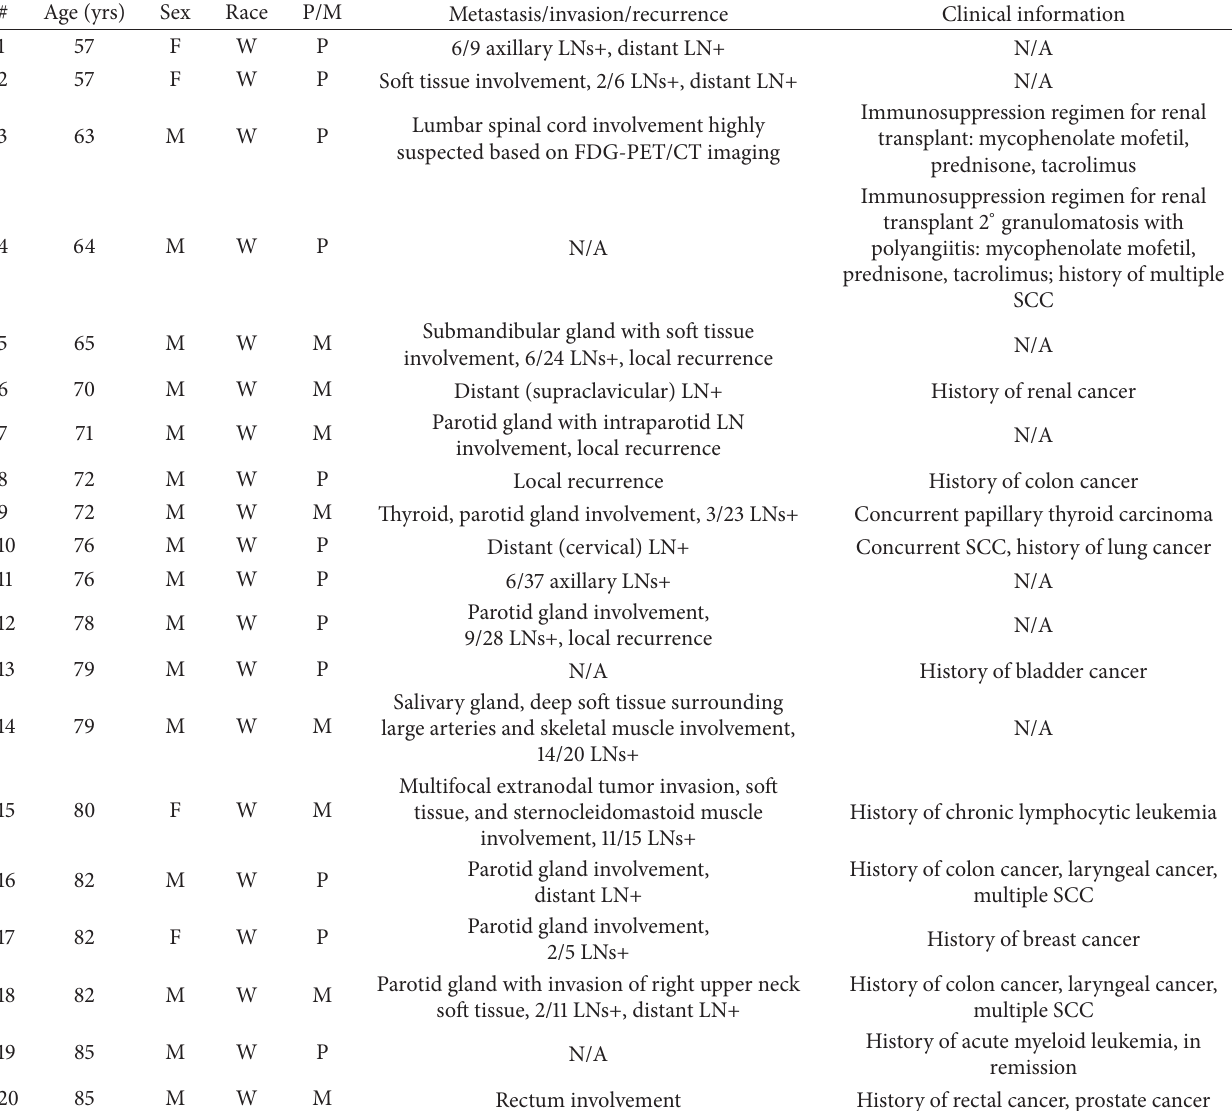
Table 1: MCC sample data. Clinical information corresponding to each of the FFPE MCC samples utilized in qRT-PCR